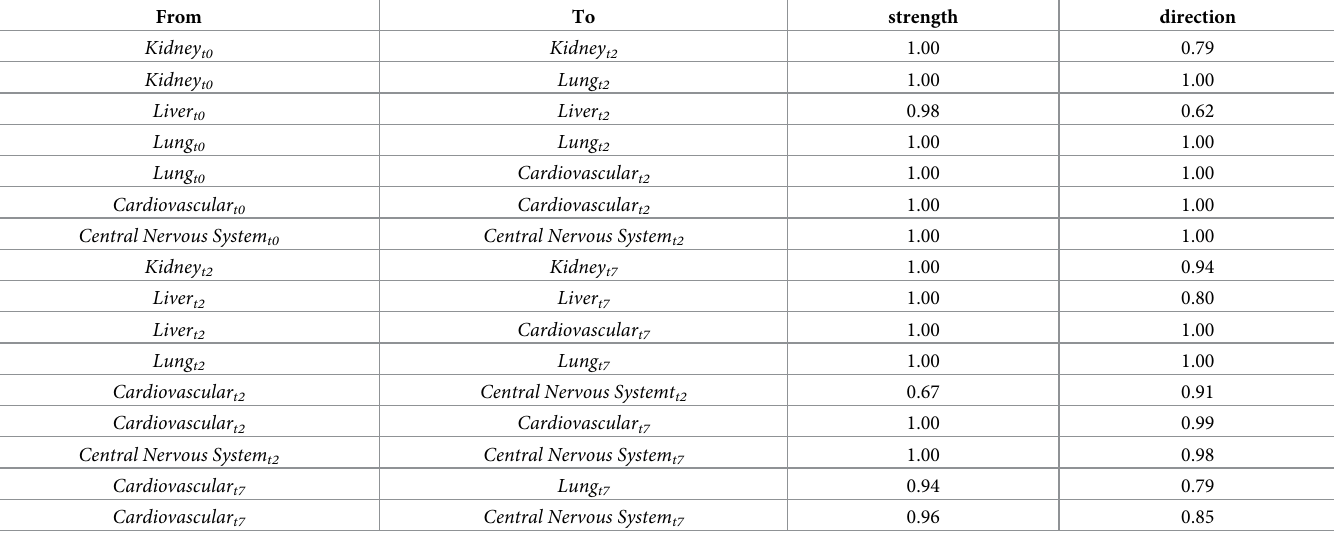
Table 1. Arcs strength and direction of the averaged dynamic Bayesian network obtained by 500 bootstrap on five organs at the intensive care unit admission, at 2 nd and 7 th day. From To strength direction Kidney t0 Kidney t2 1.00